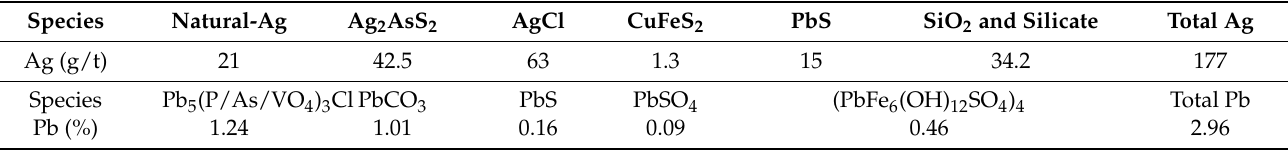
Table 2. Chemical phase analysis results of complex sulfide-oxidized mixed Pb-Ag ore sample (mass fraction, g/t, %). Species